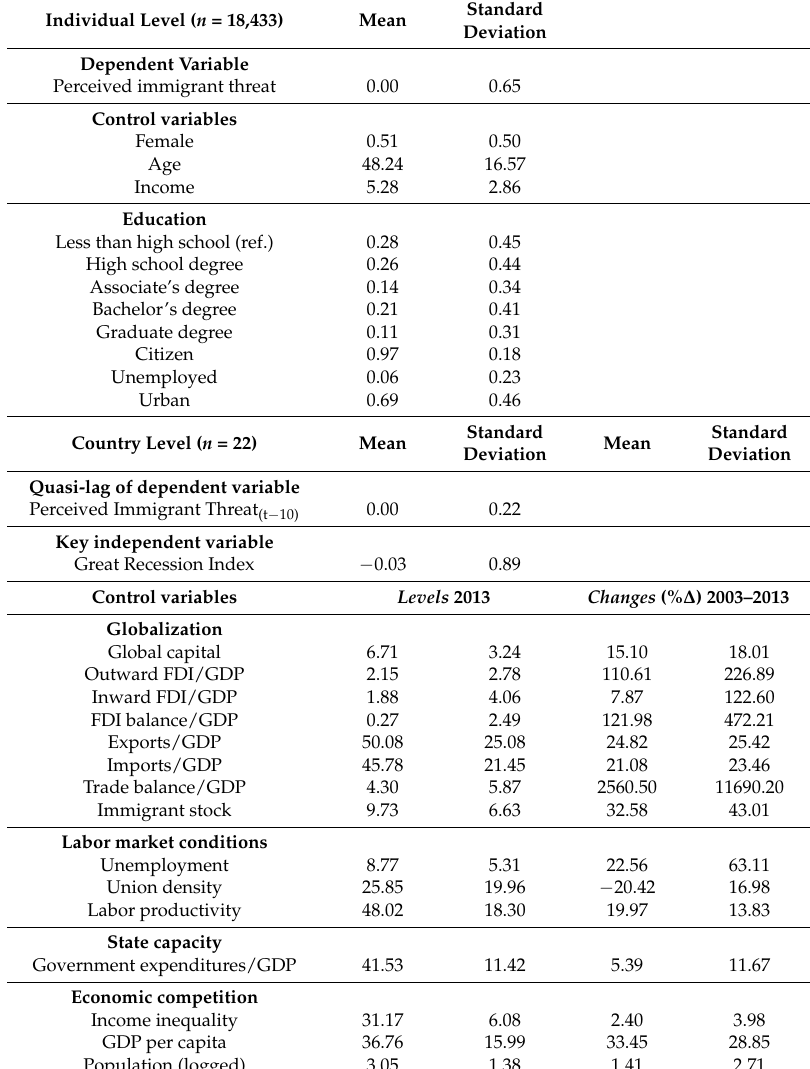
Table 3. Descriptive statistics for variables in the